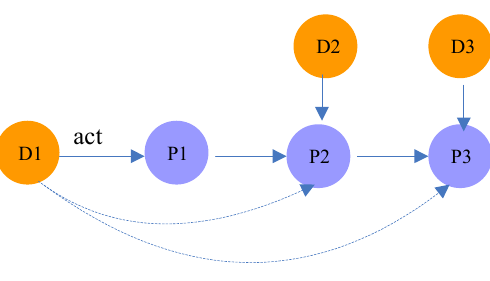
Figure 4. Illustration of meta-path DP ( n ) D .